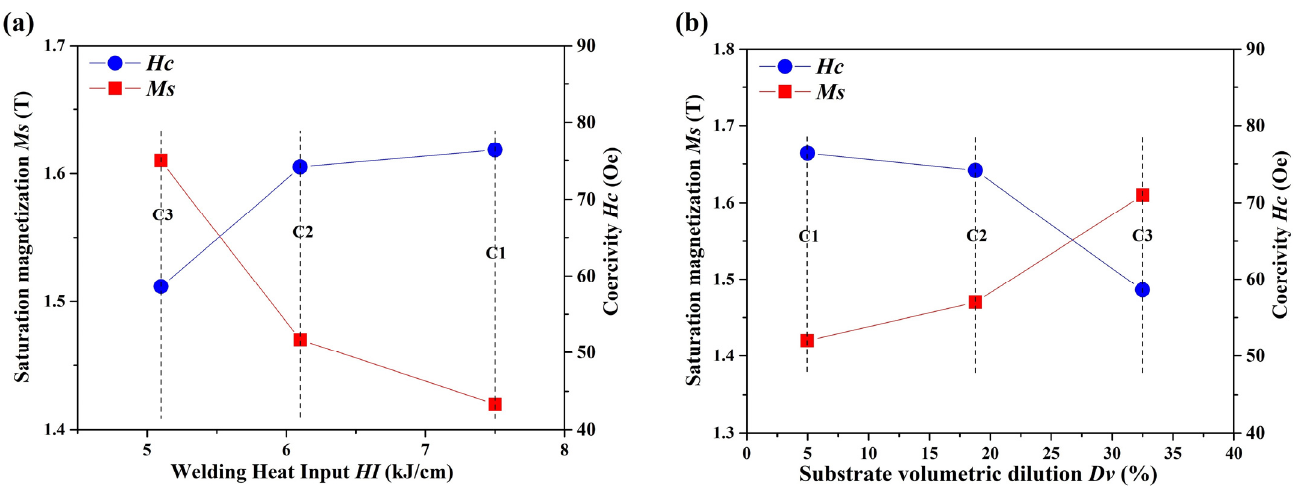
Figure 11. Correlation ( a ) between saturation magnetization Ms (or coercivity Hc) and heat input HI, and ( b ) between Ms (or Hc) and substrate volumetric dilution ratio D v for the PTA-welded coatings.